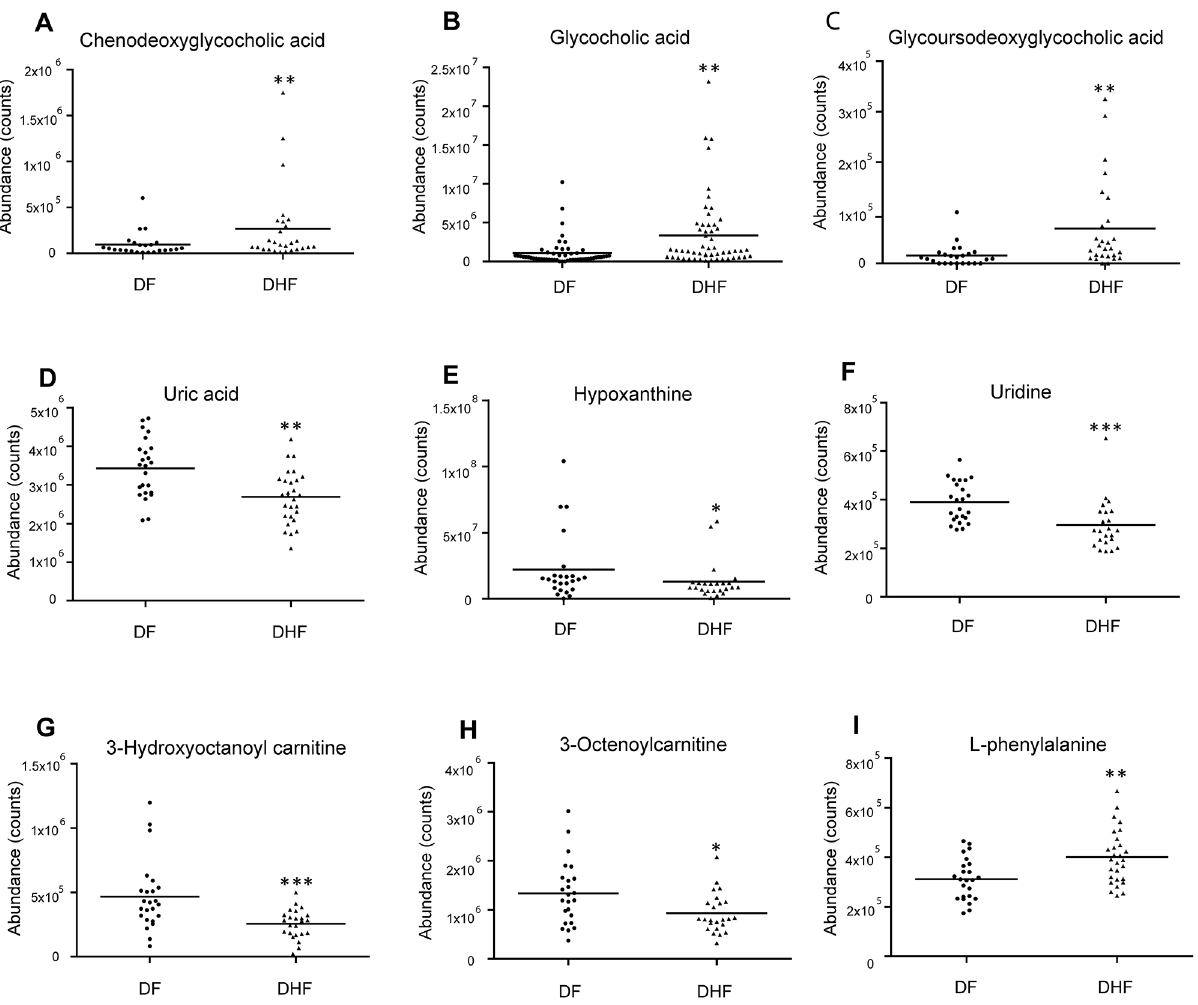
Fig 2. Box plots of representative differentially expressed metabolites between dengue fever (DF) and dengue hemorrhagic fever (DHF) patients during critical phase. A. Chenodeoxyglycocholic acid B. Glycocholic acid C. Glycoursodeoxycholic acid D. Uric acid E. Hypoxanthine F. Uridine G. 3-Hydroxyoctanoyl carnitine H. 2-Octenoylcarnitine I. L-phenylalanine. Horizontal lines represent median value. (cid:3) p < 0.05, (cid:3)(cid:3) p < 0.01, (cid:3)(cid:3)(cid:3) p < 0.001, by Mann-Whitney test. The statistical comparison was with DF levels.